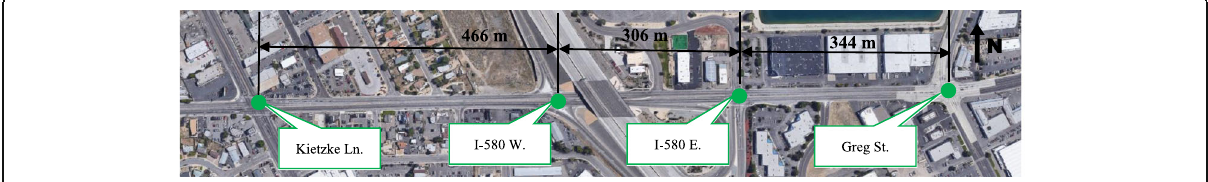
Fig. 1 Graphical illustration of the Mill St signalized corridor